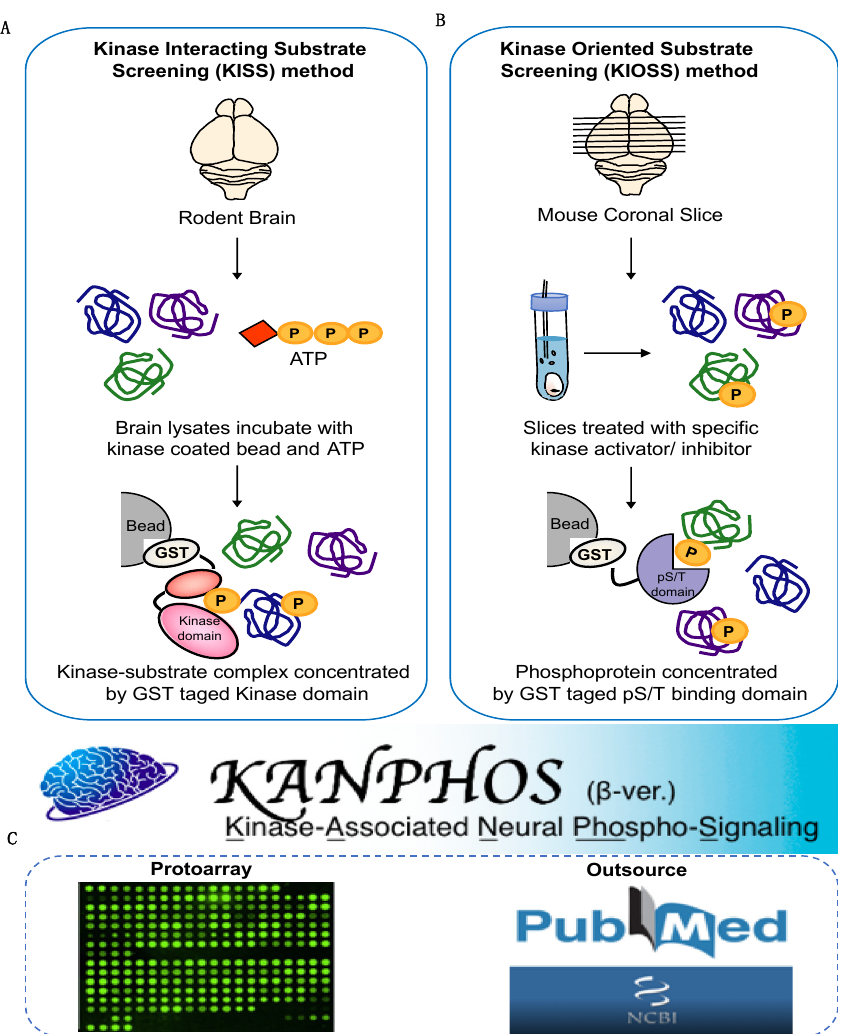
Figure 1. The schema for the construction of KANPHOS. ( A ) Schematic representation of the Kinase- Interacting Substrate Screening (KISS). In KISS method, rodent brain lysates were extracted and incubated with specific kinase-tag beads and ATP. The bound proteins were subjected to liquid chromatography tandem mass spectrometry (LC-MS/MS) to identify the phosphorylated proteins and their phosphorylation sites. ( B ) Schematic representation of the Kinase-Oriented Substrate Screening (KIOSS) method. In KIOSS method, mouse coronal brain slices were treated with specific kinase activator/receptor agonist or kinase inhibitor/receptor antagonist to stimulate a specific signaling pathway and then incubated with GST tag pS/T binding domain (such as 14-3-3 ζ ) to enrich phosphoproteins. The bound proteins were subjected to LC-MS/MS to identify the phosphorylated proteins and their phosphorylation sites. ( C ) In addition to our own developed phosphoproteomic method, data were also manually curated from the literature and